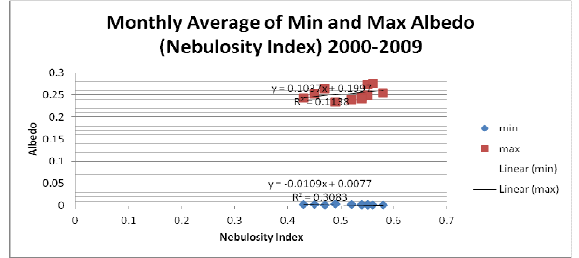
Figure 7. Nebulosity Index and Albedo Trend